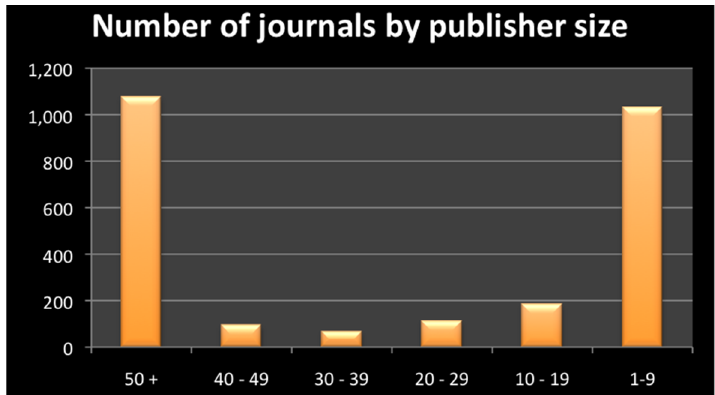
Figure 1. Article processing charge (APC) journals in DOAJ by publisher size.